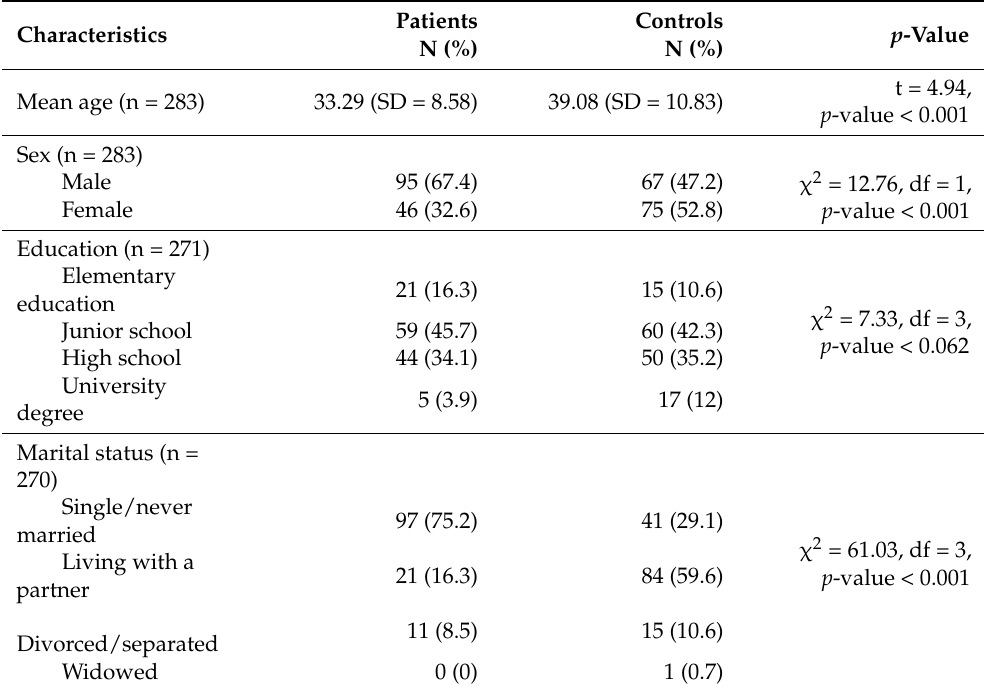
Table 1. Demographic characteristics of patients with schizophrenia and